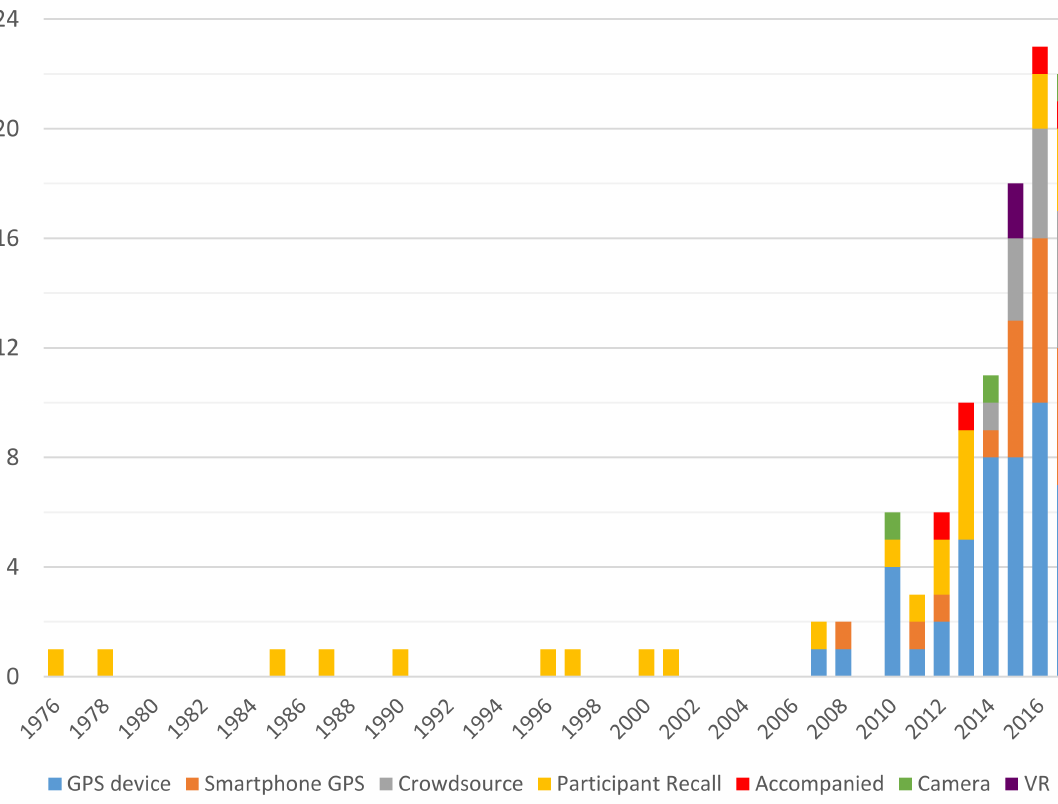
Figure 3. Revealed preference bicycle route choice publications for whole journeys (112) sorted by method